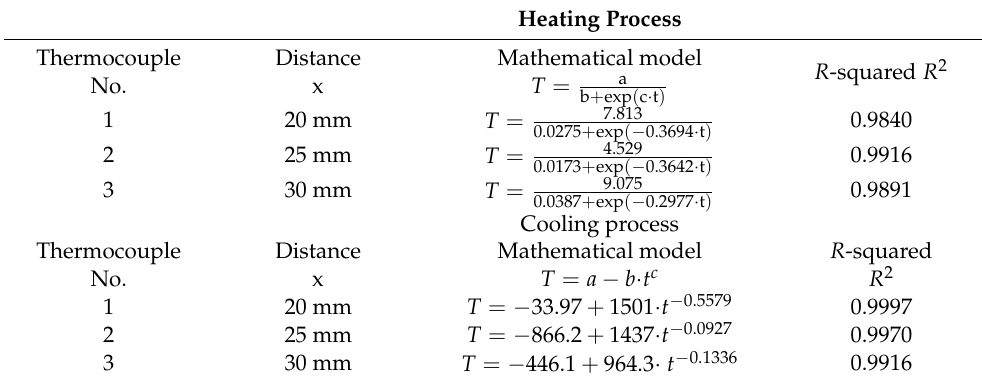
Table 4. Mathematical models for temperature curves of the heating and cooling of the welding process in the axis